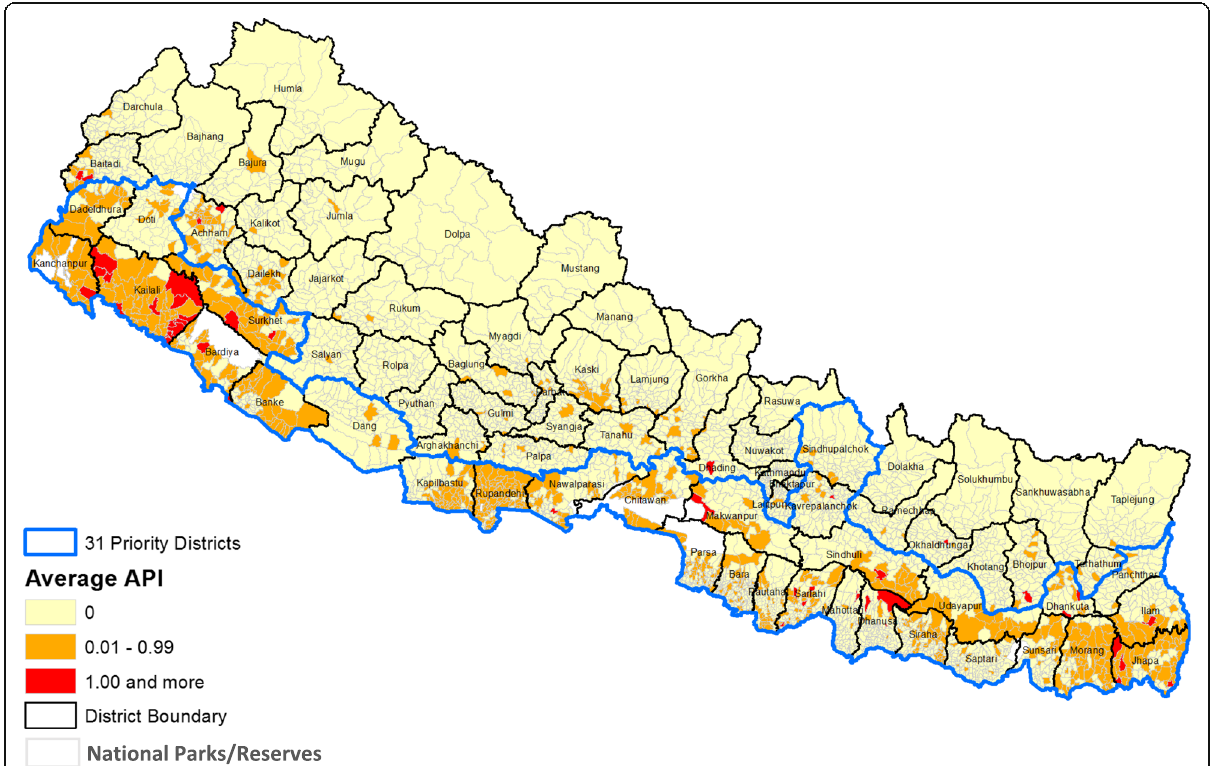
Fig. 4 Average annual API from 2009 to 2011 (disease